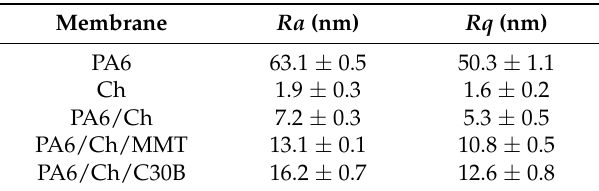
Ra —the roughness average, Rq —the root mean square.